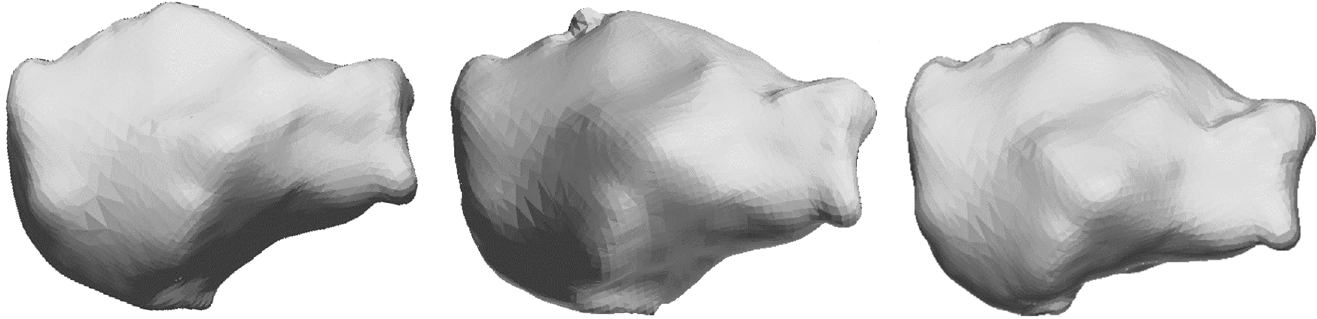
Fig 3. An example of reconstructed SSM of right calcaneus using (from left to right) the 25th, 50th and 75th quartile of the spherical harmonic coefficients.